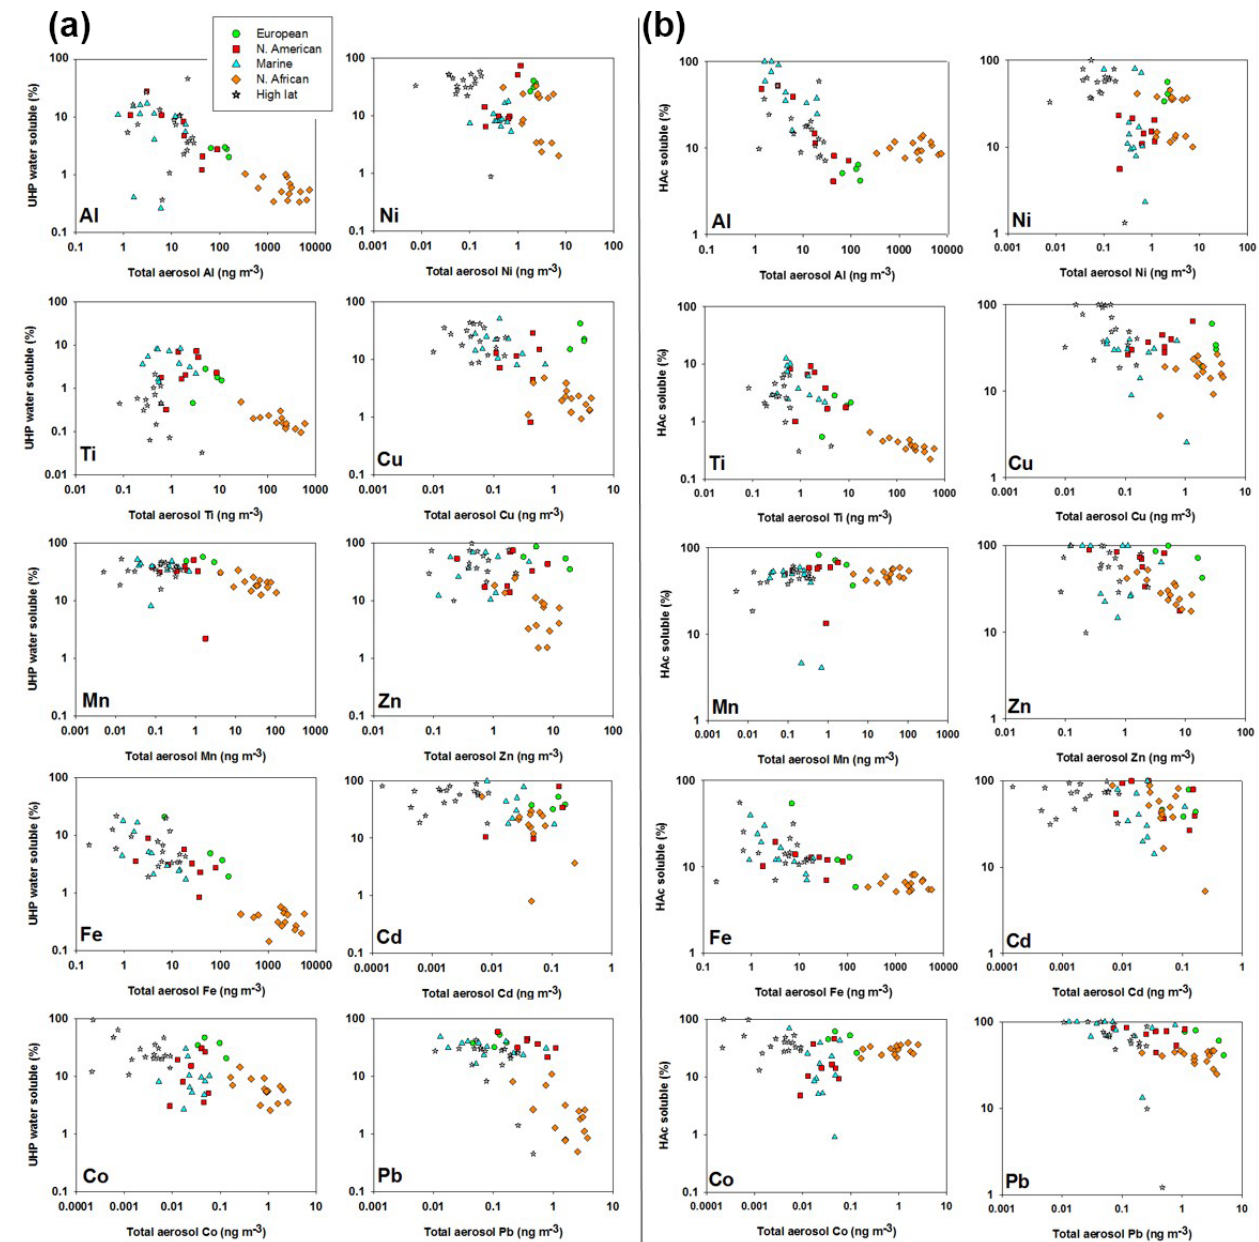
Figure 4. (a) Percentage of UHP water-soluble TE (calculated from Eq. 1) versus total aerosol TE (ngm − 3 ) ; (b) percentage of 25% acetic acid soluble TE (calculated from Eq. 2) versus total aerosol TE (ngm − 3 ) . Data are plotted on log–log